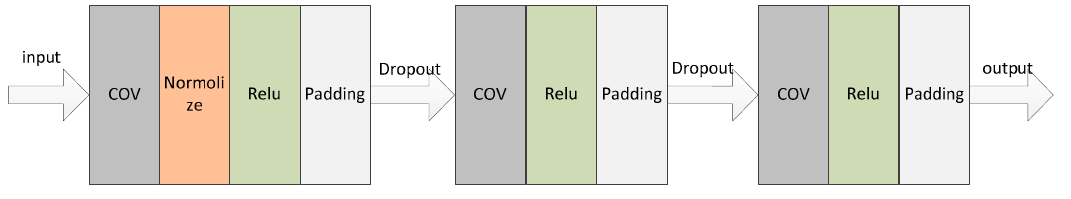
Figure 5. Structure of the convolution unit. ReLU: rectified linear unit.